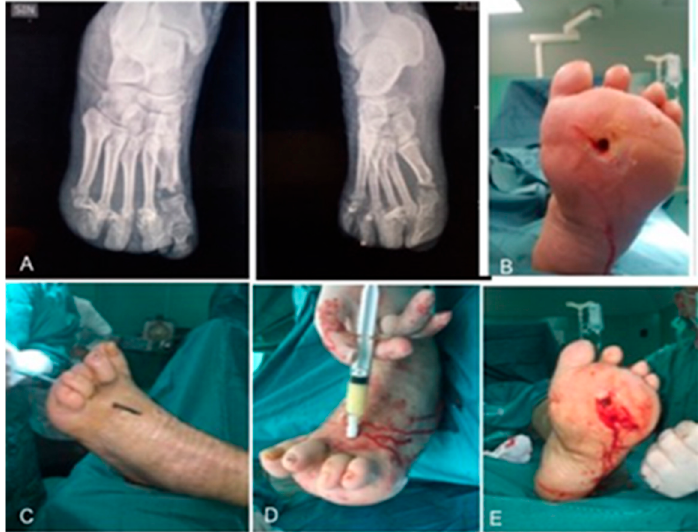
Figure 2. The plain radiograph of foot ( A ), a wound site at T0 with involvement of deep structures forefoot plantar lesion ( B ) and plantar-dorsal lesion ( C ). Description of the technique, IFWM (Integra ® Flowable Wound Matrix) is injected through a cannula ( D , E ).